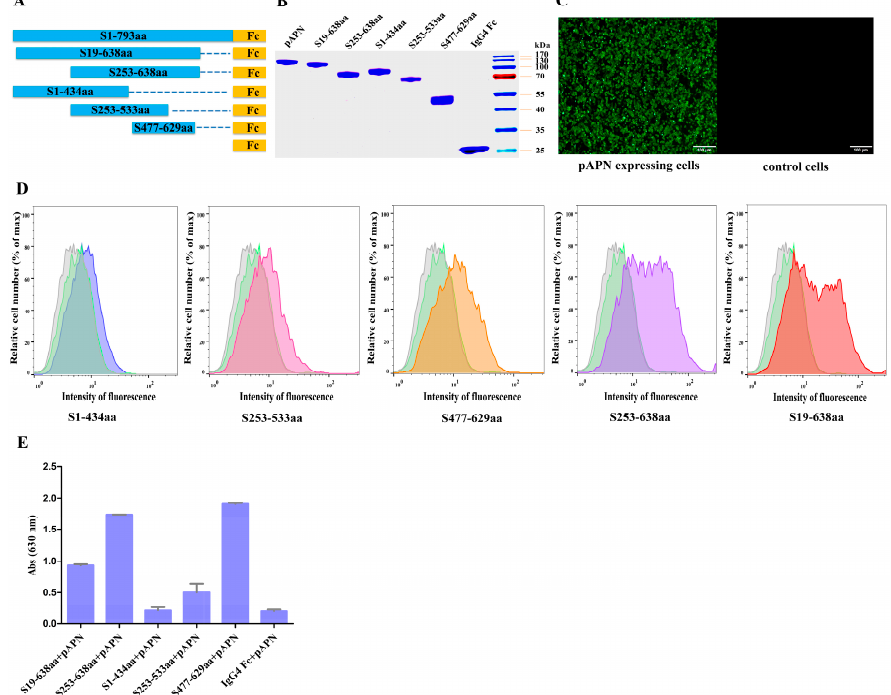
Figure 2. Localization of the receptor-binding region of PEDV S1. ( A ) Diagram of the codon-optimized full-length S1 and the five truncated S1 variant constructs of the CHGD-01 strain, including the S 19–638 fragment, which contains the S1 NTD and CTD; the S 1–434 fragment, which contains the S1 NTD; the S 253–533 fragment; the S 477–629 fragment; and the S 253–638 fragment, which is a CTD of S1; ( B ) Purified truncated S1 variants of CHGD-01 with a C-terminal IgG 4 Fc tag, pAPN with a C-terminal His 6 tag, and IgG 4 Fc proteins were detected by SDS-PAGE; ( C ) The transfection efficiency was determined by performing an indirect immunofluorescence assay. HEK-293T cells transfected with a pAPN gene-containing plasmid ( left ) and cells transfected with an empty vector ( right ) were used for detection. Mouse anti-His monoclonal antibody and Alexa Fluor ® 488 anti-mouse IgG (H + L) antibody were used before detection. The green fluorescence represents the expressed pAPN protein; ( D ) The binding between five truncated S1 variants and pAPN-expressing cells was investigated by performing flow cytometry. HEK-293T cells were transfected with a pAPN gene-containing plasmid. After 48 h, the cells were resuspended with the S 19–638 , S 253–638 , S 1–434 , S 253–533 , and S 477–629 proteins (50 μ g/mL), followed by treatment with FITC-labeled anti-human IgG 4 Fc antibodies. Then FACS was performed. pAPN-transfected cells untreated with protein (grey shade) or treated with IgG 4 Fc protein (green shade) were used as controls; ( E ) An ELISA was performed to detect the binding between five truncated S1 variants and pAPN, IgG 4 Fc protein was used as a control. ELISA plates were coated with S 19–638 , S 253–638 , S 1–434 , S 253–533 , S 477–629 , or IgG 4 Fc proteins and blocked with BSA. The plates were then incubated with the pAPN protein. The TMB substrate was added after incubation with mouse anti-His monoclonal antibody and HRP-conjugated goat anti-mouse IgG antibody. The experiment was carried out three times, and the data from a representative experiment are shown. Error bars indicate the standard errors of the means. An ELISA was also performed to examine the associations between the S1 fragments and pAPN. The results showed that the S 19–638 , S 253–638 , and S 477–629 fragments bound to pAPN with high affinity, while the S 253–533 fragment bound to pAPN with very low affinity. In contrast, the S 1–434 fragment and IgG 4 Fc protein did not bind to pAPN (Figure 2E). These results further confirmed that the RBD is located within the CTD of the PEDV S1 domain.